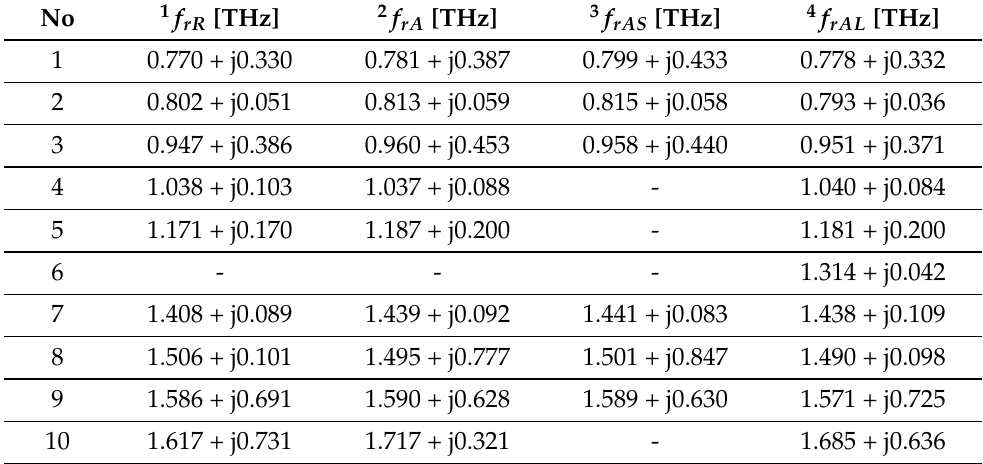
1 f rR : Eigenfrequencies for the patch antenna of Figure 9 without the feeding line, based on the recursive formulation of Section 2.2.1; 2 f rA : Eigenfrequencies for the patch antenna of Figure 9 without the feeding line, based on the auxiliary field-based formulation of Section 2.2.2; 3 f rAS : Eigenfrequencies for the finite grounded substrate of Figure 9 in the absence of the patch radiator and the feeding line, based on the auxiliary field-based formulation of Section 2.2.2; 4 f rAL : Eigenfrequencies for the patch antenna of Figure 9, based on the auxiliary field-based formulation of Section